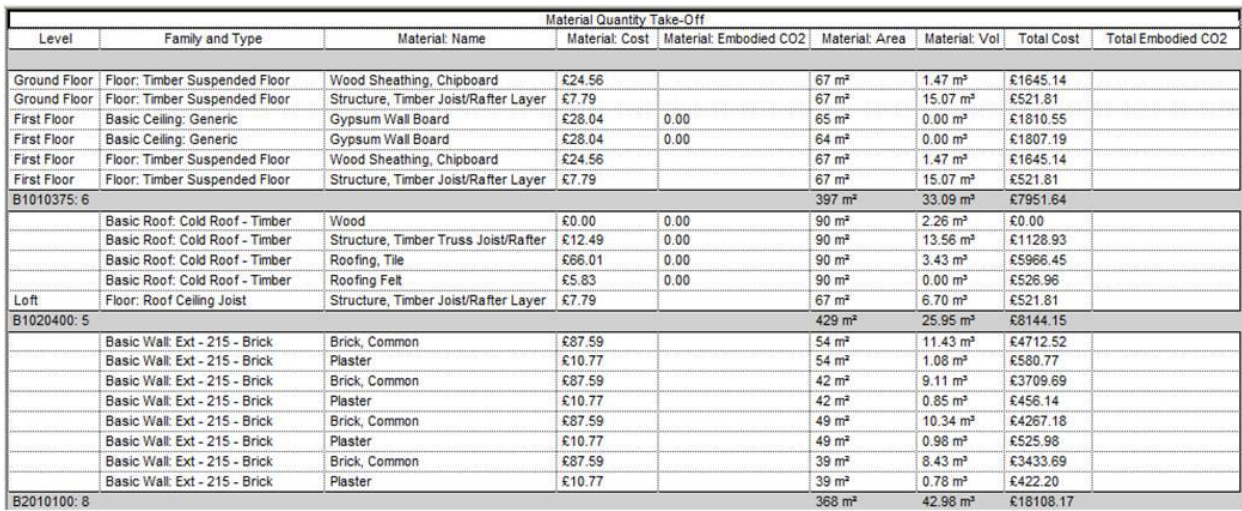
Figure 7. Material take-off function in BIM (Revit 2013)—pre-refurbishment.